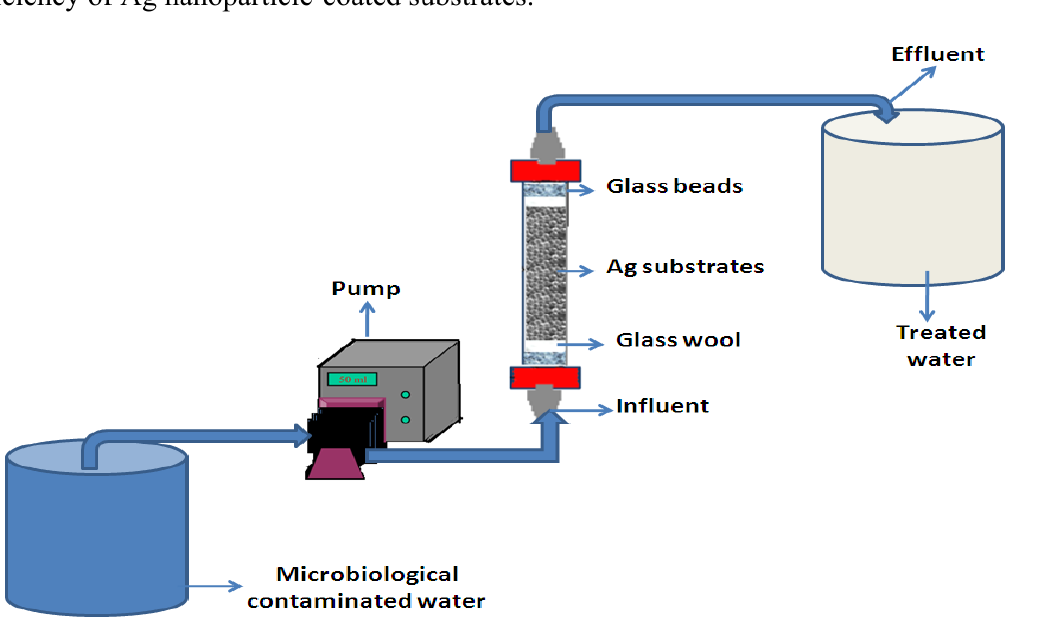
Figure 1. Schematic diagram of laboratory-scale setup to evaluate the antibacterial efficiency of Ag nanoparticle-coated